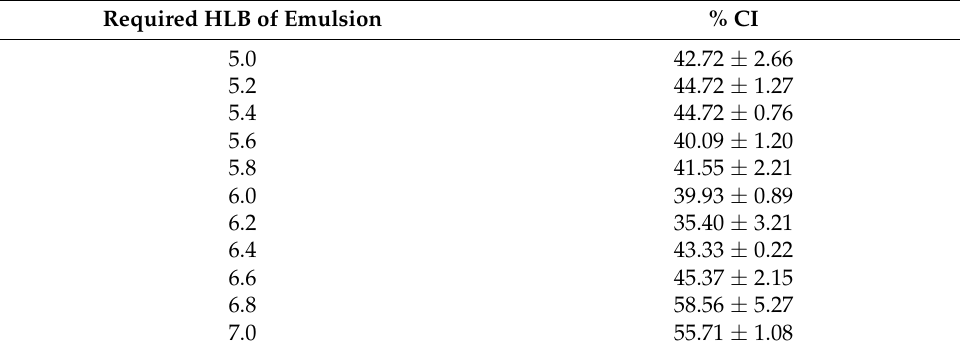
Table 8. Required HLB values 5.0–7.0 of emulsion and %